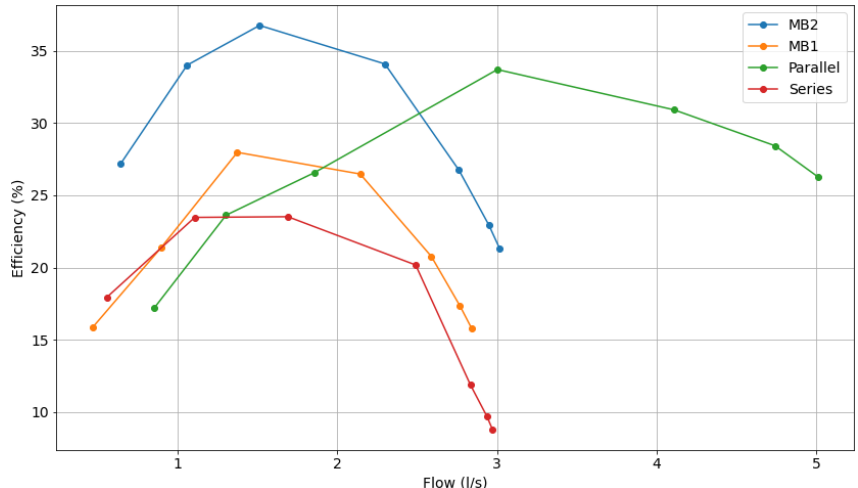
Figure 13. Comparative characteristic curve of the energy efficiencies of pumps operating at 40 Hz.